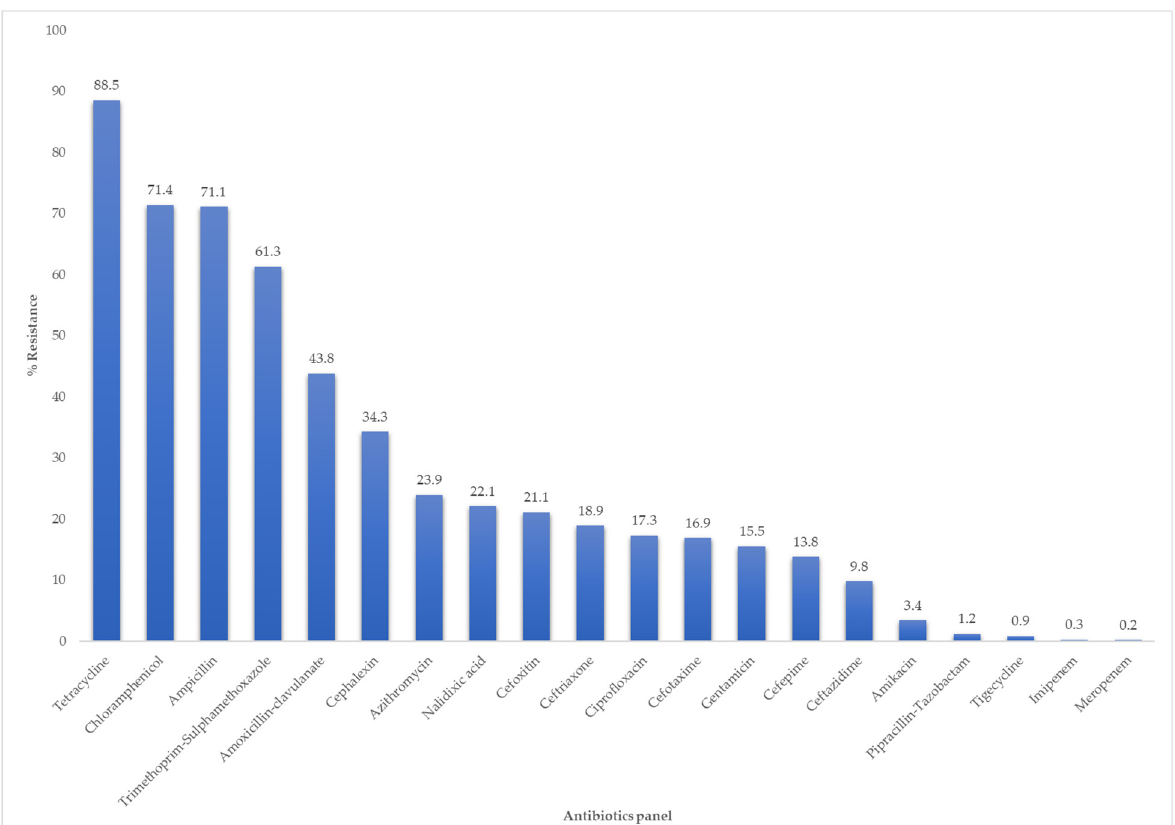
Figure 2. The overall percentage of antibiotic resistance in E. coli isolated across the pig production chain. When stratified by site of collection, the highest percentage resistance was observed in the farm isolates. No tigecycline resistance was recorded in both truck and abattoir isolates (Figure 3). The overall multidrug resistance (MDR) rate was 71.2% ( n = 743). The highest preva- lence of MDR was found on the farm 74.6% ( n = 723) while truck and abattoir MDR rate was 51.1% ( n = 43) and 50.3% ( n = 161), respectively (Table 1). The difference in the MDR rate between the different sampling sites was statistically significant (Table 1). None of the isolates were pan-drug resistant (Table 1). Two hundred and two (202) MDR patterns were recorded in the study, the most common pattern being AMP-SXT-TET-CHL, found in